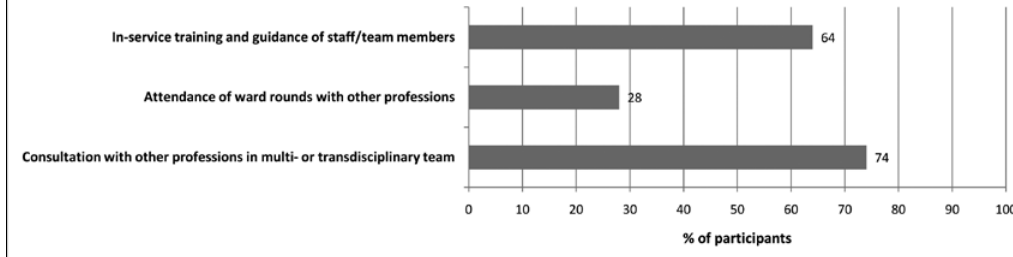
Fig. 3. Speech-language therapists’ roles in intervention specifically directed at staff and team members ( N =39) .